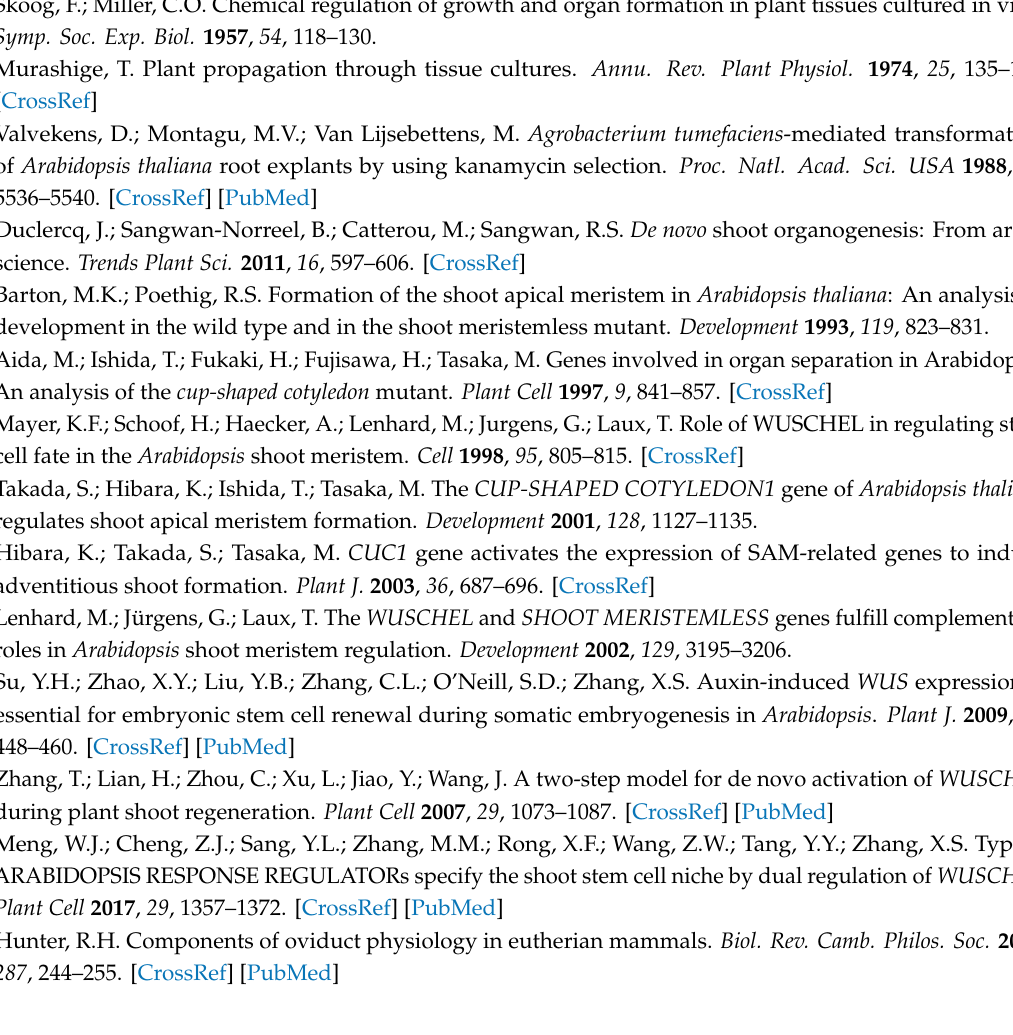
Figure S1: The e ff ect of sodium butyrate (NaB) on callus growth of protoplast-derived calli of tobacco, Figure S2: The e ff ect of sodium butyrate (NaB) on adventitious shoot formation of protoplast-derived calli of tomato, Figure S3: The e ff ect of high concentration of sodium butyrate (NaB) on adventitious shoot formation in cotyledon explants of